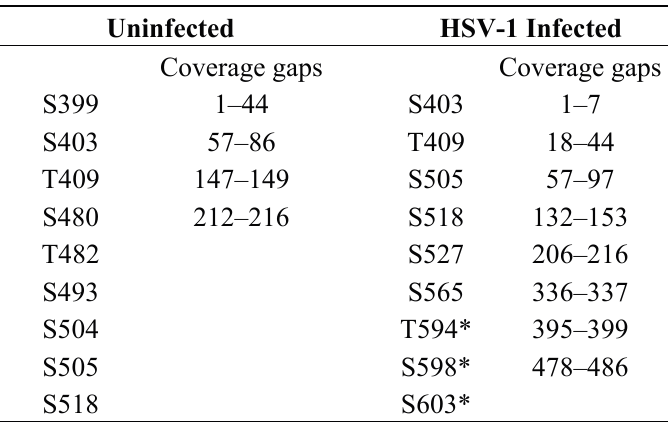
Table 1. Sites of Phosphorylation on